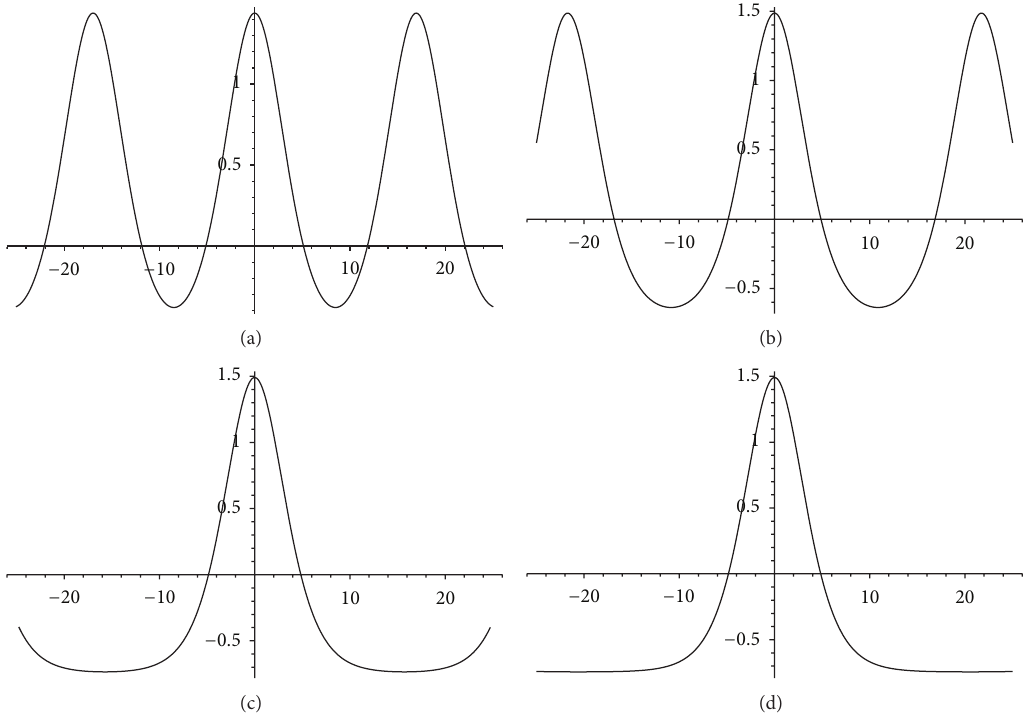
Figure 4: The varying process for graphs of 𝑢 7 (𝜉) when 𝑐 > 𝛼 and 𝑔 → 𝑔 0 − 0 where 𝛼 = 𝛽 = 𝛾 = 1 , 𝑐 = 2 , and (a) 𝑔 = 𝑔 0 − 10 −1 . (b) − 10 −2 . (c) 𝑔 = 𝑔 − 10 −4 . (d) 𝑔 = 𝑔 − 10 −6 𝑔 = 𝑔 0 0 0